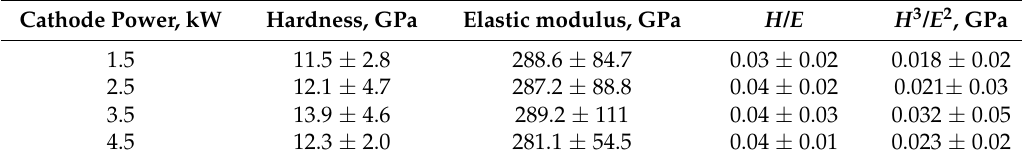
Table 2. Influence of the sputtering power on mechanical properties of the Cr 2 AlC coatings. Cathode Power,